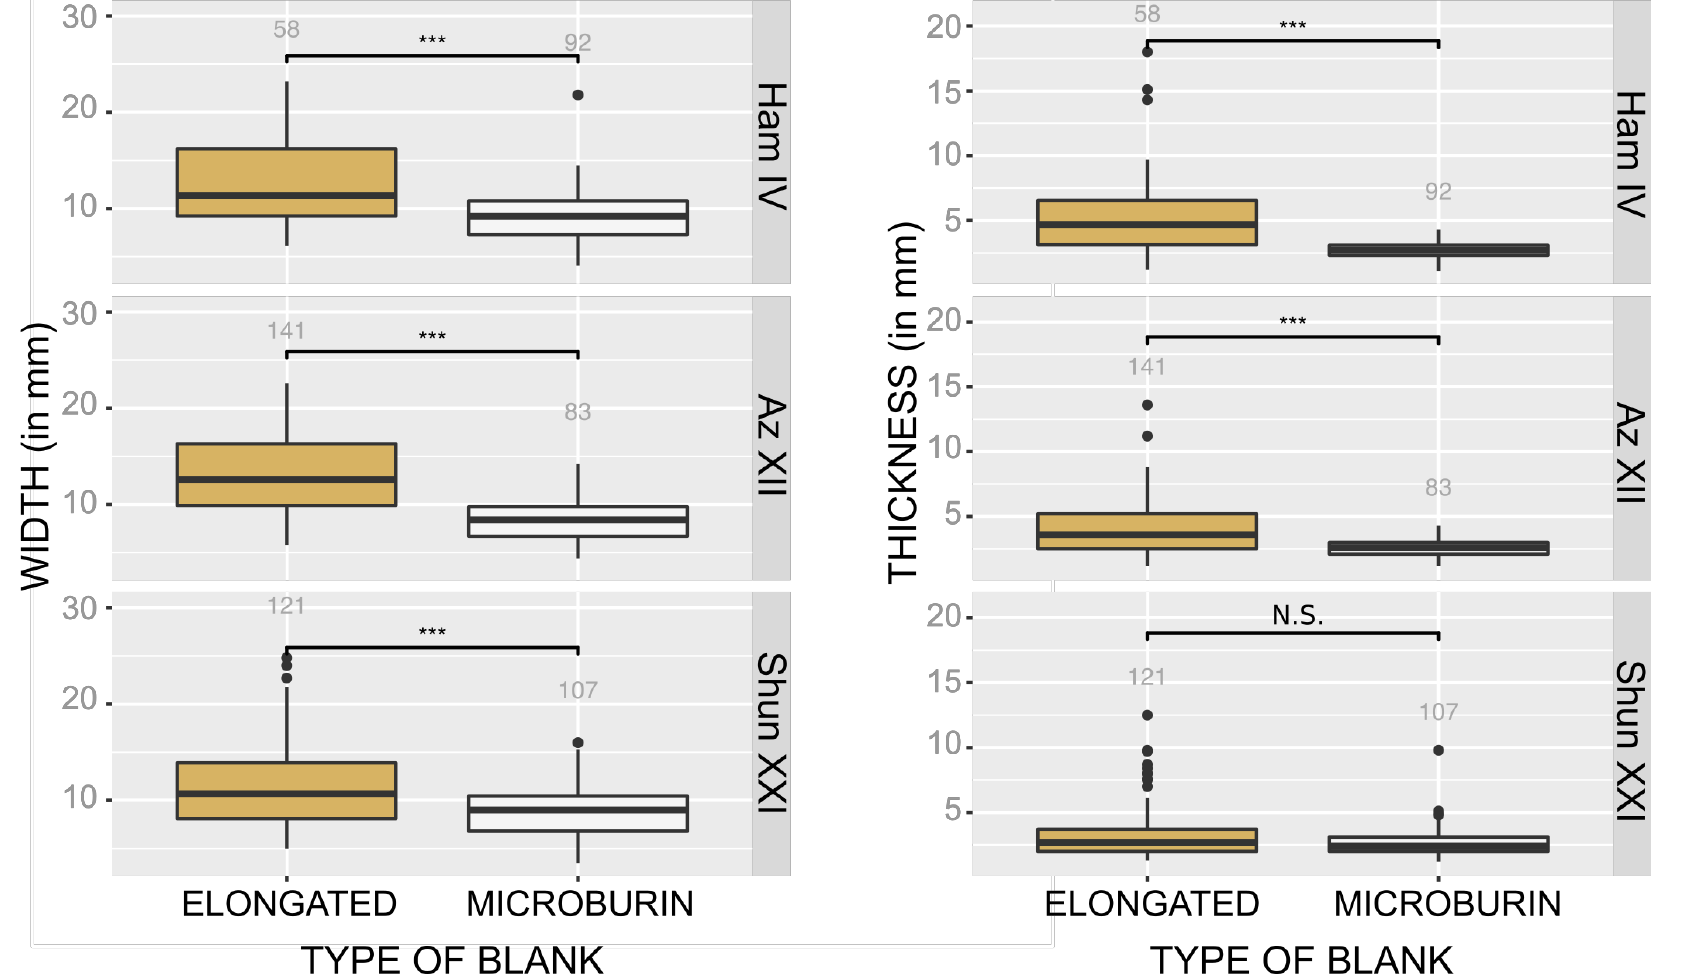
Figure 10. Comparisons of width and thickness of microburins and elongated blanks at Hamifgash IV, Azariq XII and Shunera XXI. Az - Azariq; Shun - Shunera; Ham -